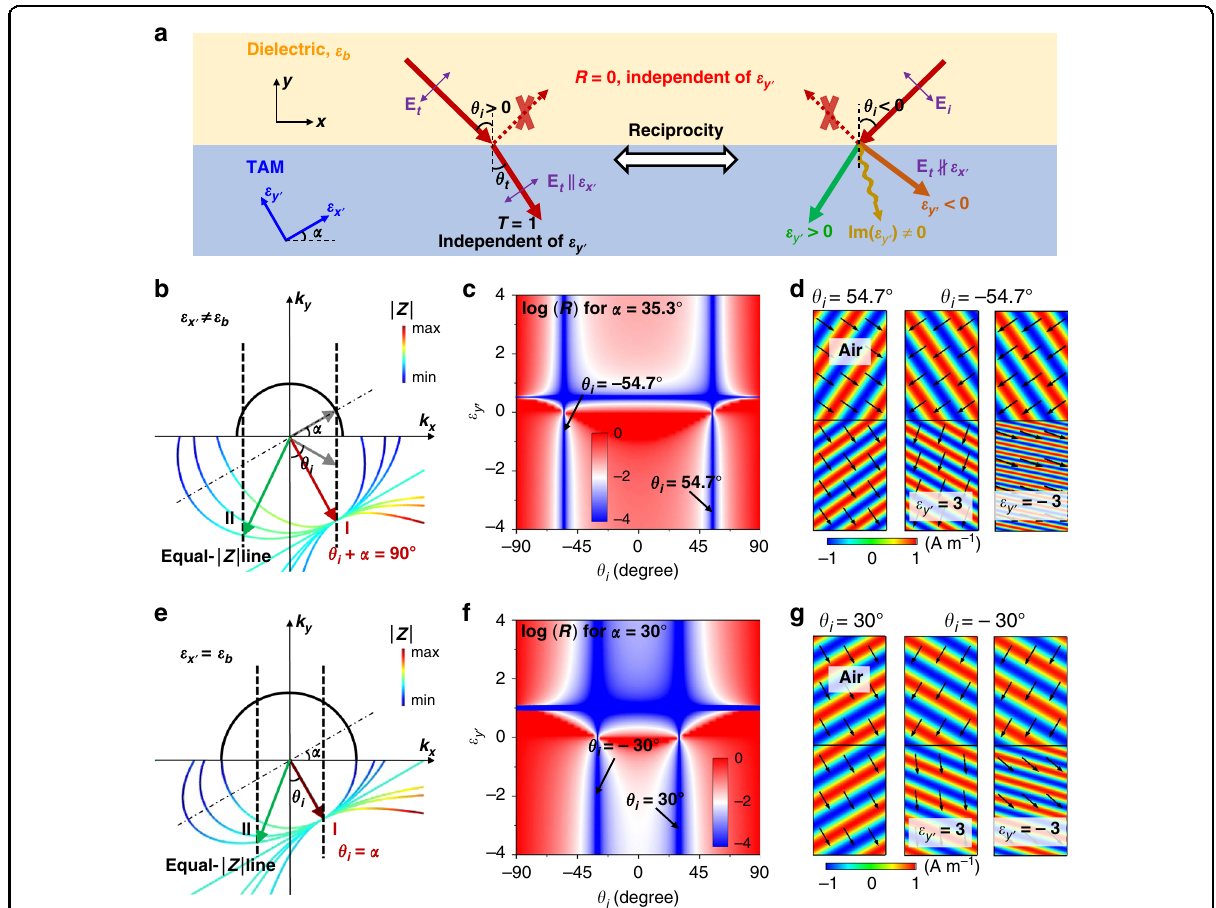
Fig. 1 Simultaneous realization of ε y ′ -independent Brewster effect and ε y ′ -controlled transmission in TAMs. a Illustration of the Brewster effect between a background dielectric ε b and a nonmagnetic TAM. Due to the protection of reciprocity, the wave impedance in the left case θ i > 0 is exactly the same as that in the right case θ i < 0. The transmission in the right (left) case is dependent (independent) on ε y ′ . The upper plane of EFCs of the background dielectric (black solid lines), and the lower plane of EFCs of the TAM when ε x ′ and α are fi xed but ε y ′ is varied (color solid lines), regarding the cases of b ε x ′ ≠ ε b and e ε x ′ ¼ ε b , respectively. The colors denote the magnitude of wave impedance Z j j . The black dashed vertical lines are the equal- Z j j lines, which intersect with the EFCs at points I and II, respectively. The gray arrows denote the wave vectors of the incident and re fl ected beams determined by the EFCs of the background dielectric, and the red and green arrows denote the refracted beam determined by the EFCs of the TAM. Calculated re fl ectance as functions of θ i and ε y ′ for TM-polarized waves incident from free space onto the TAM with c ε x ′ ¼ 2 and α ¼ 35 : 3 (cid:2) , or f ε ¼ 1 and α ¼ 30 (cid:2) , respectively. Simulated distributions of magnetic fi elds (color) and group velocity (arrows) for the TAM with x ′ d ε x ′ ¼ 2 and α ¼ 35 : 3 (cid:2) under θ i ¼ 54 : 7 (cid:2) (left) or θ i ¼ (cid:3) 54 : 7 (cid:2) (middle and right), or g ε x ′ ¼ 1 and α ¼ 30 (cid:2) under θ i ¼ 30 (cid:2) (left) or θ i ¼ (cid:3) 30 (cid:2) (middle and right), respectively. We set ε y ′ ¼ 3 (left and middle) or ε x ′ ¼ (cid:3) 3